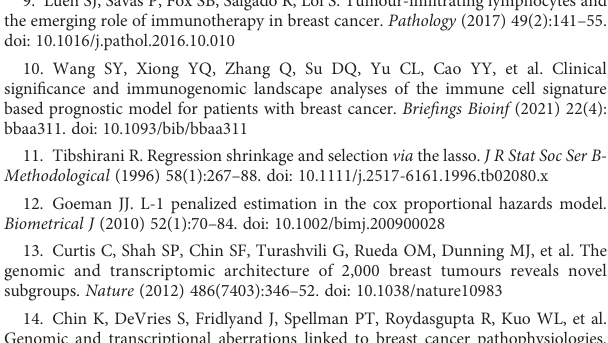
SUPPLEMENTARY FIGURE 10 The correlation analysis of in fi ltrative immune cells with LNPRS by 5 algorithms in the TCGA cohort. (A – Q) The relationship between immune cells and gene expression.